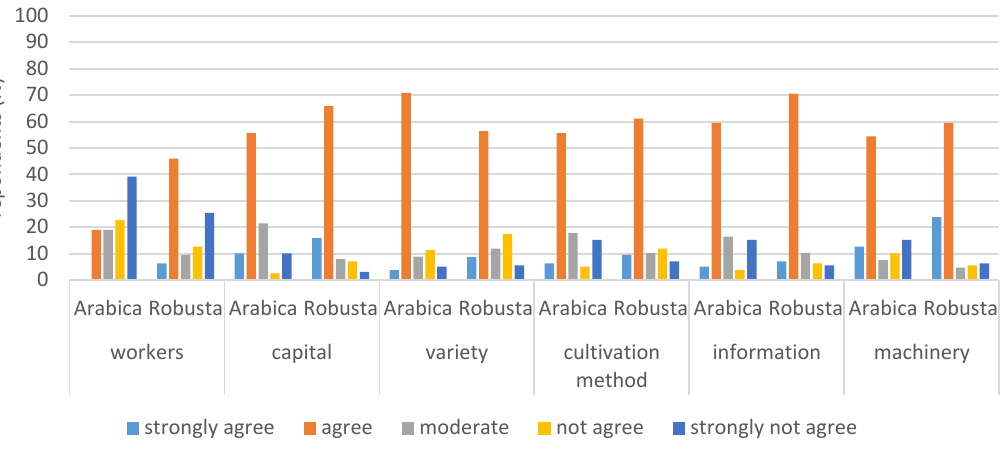
Figure 3. Distribution farmers’ assessment of agriculture input Figure 3. Dis tribution farmers’ assessment of agriculture input barriers.